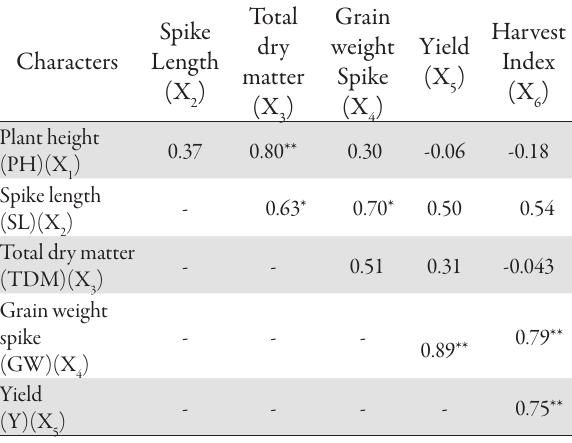
Tab. 3. Phenotypic correlation coefficient among six characters of wheat ( Triticum aestivum L)